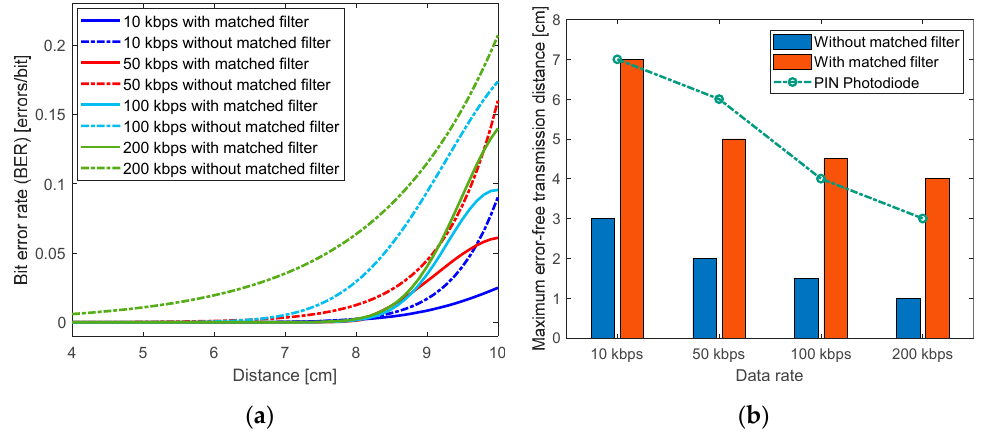
Figure 9. Effect of the matched filter on improving the system performance regarding ( a ) the bit error rate (BER) at different distances and ( b ) the maximum error-free transmission distance.